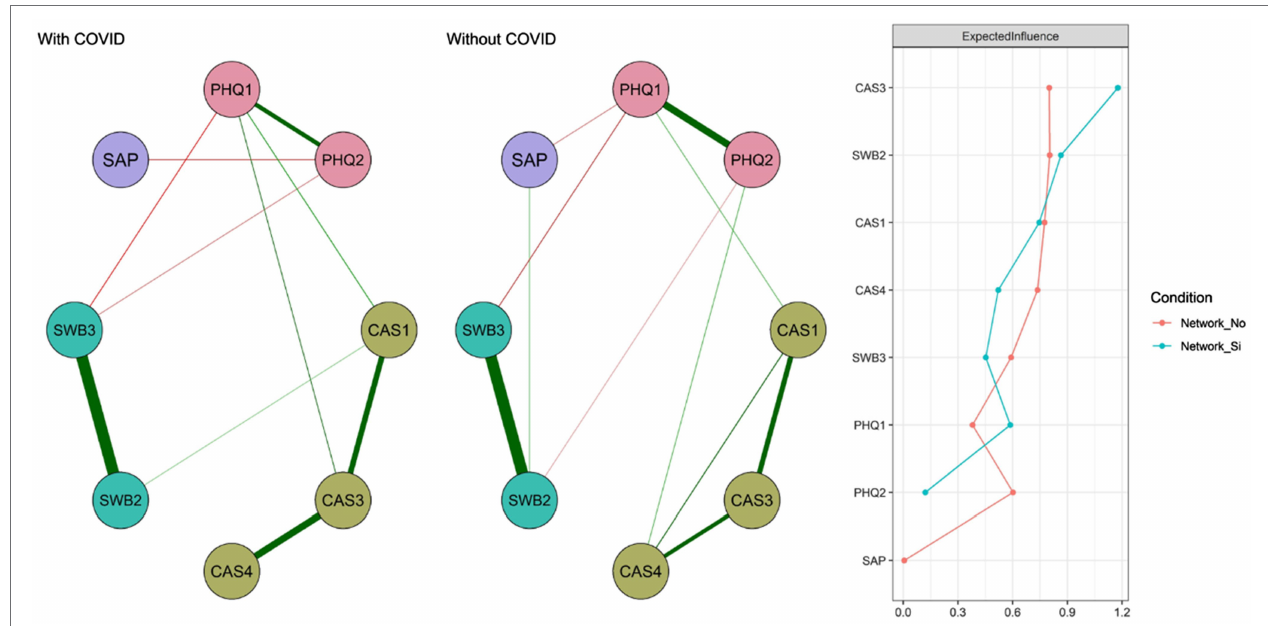
FIGURE 3 | Networks according to the presence or absence of COVID-19 diagnosis in the student. Network_No indicates the centrality measure for the Without COVID-19 group and Network_Yes for the With COVID-19